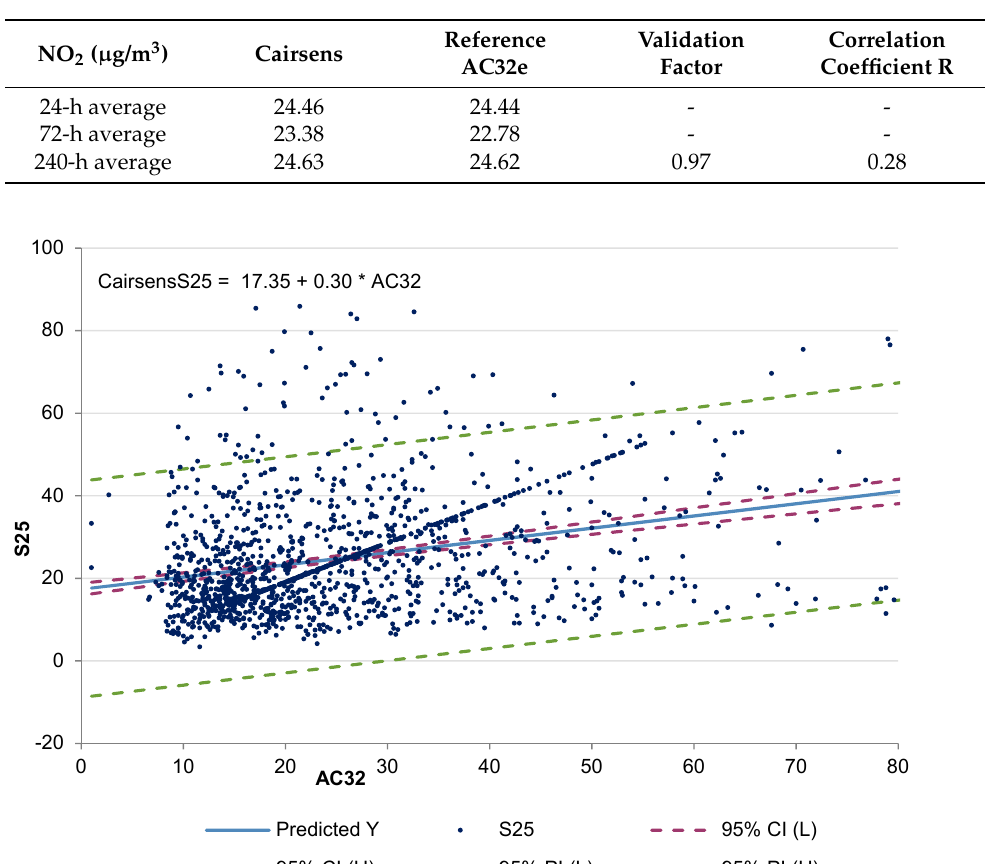
Figure 6. Distribution of NO 2 values throughout the year-long measurement: ( a ) box plot for individual sensors and ( b ) histogram of hourly averages (overall averaged values of all sensors).